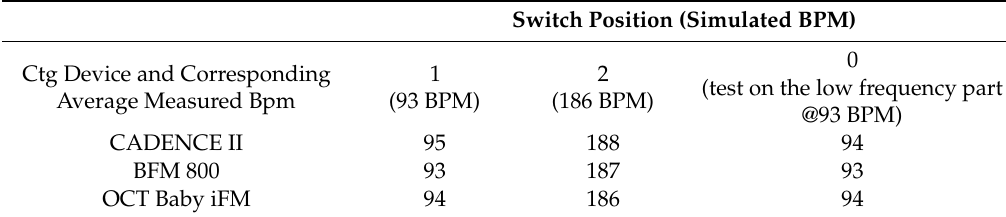
Table 2. The comparison outputs of the designed mechanical heart rate mechanical simulator device and settings values.